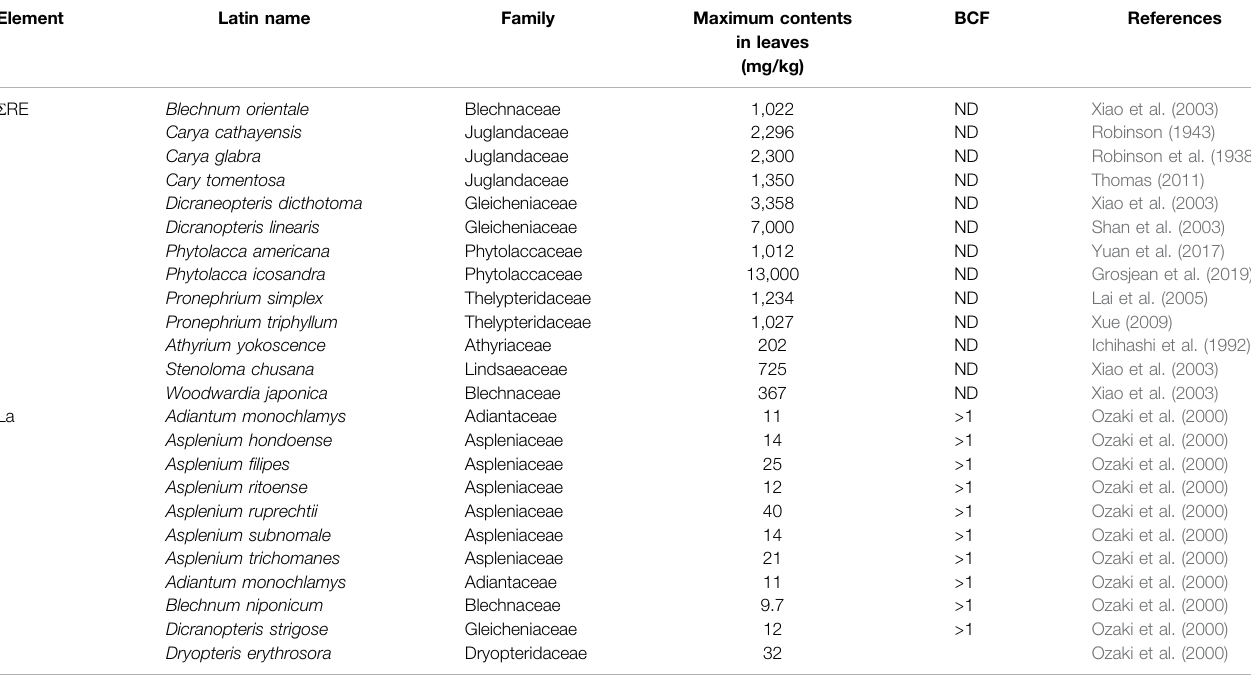
TABLE 5 | Concentrations of rare earth element (RE) in hyperaccumulator plants (mg/kg) – A hyperaccumulation threshold of 1,000 and 100 mg/kg was adopted for the fi rst 10 species and three species respectively.